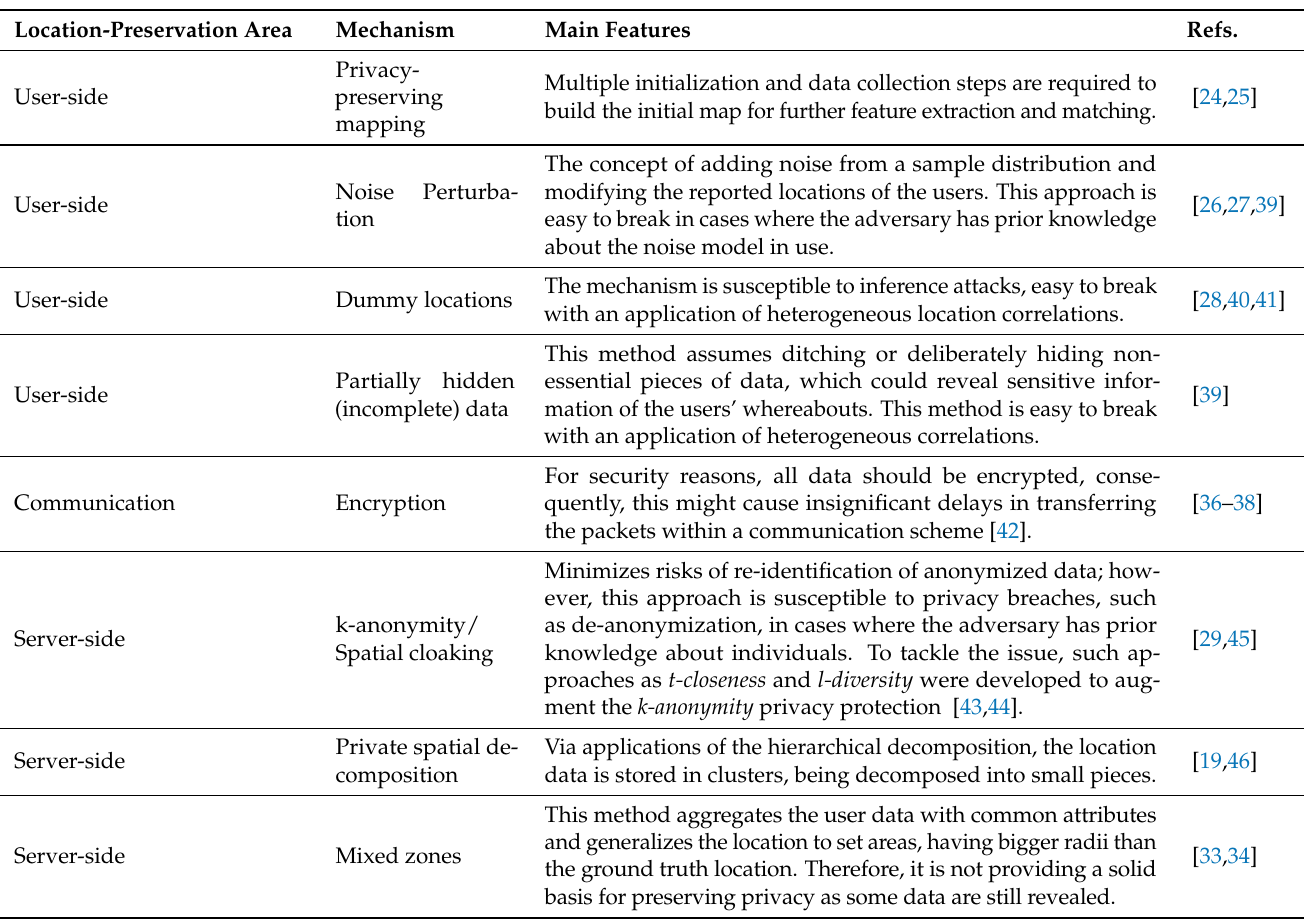
Table 1. Overview of LPPM in the